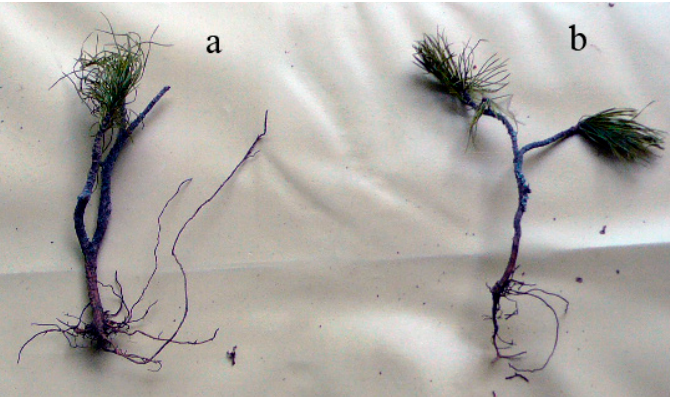
Figure 5. The relationship between age and height for the studied undergrowth of Pinus sibirica (the N value is 579).